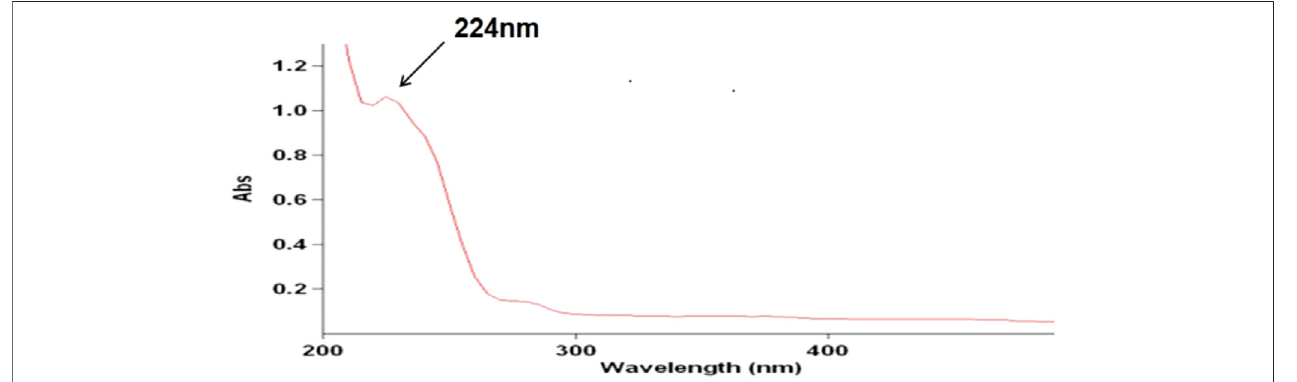
FIGURE 1 | The ultraviolet absorption spectrum of Osmanthus fragrans seeds